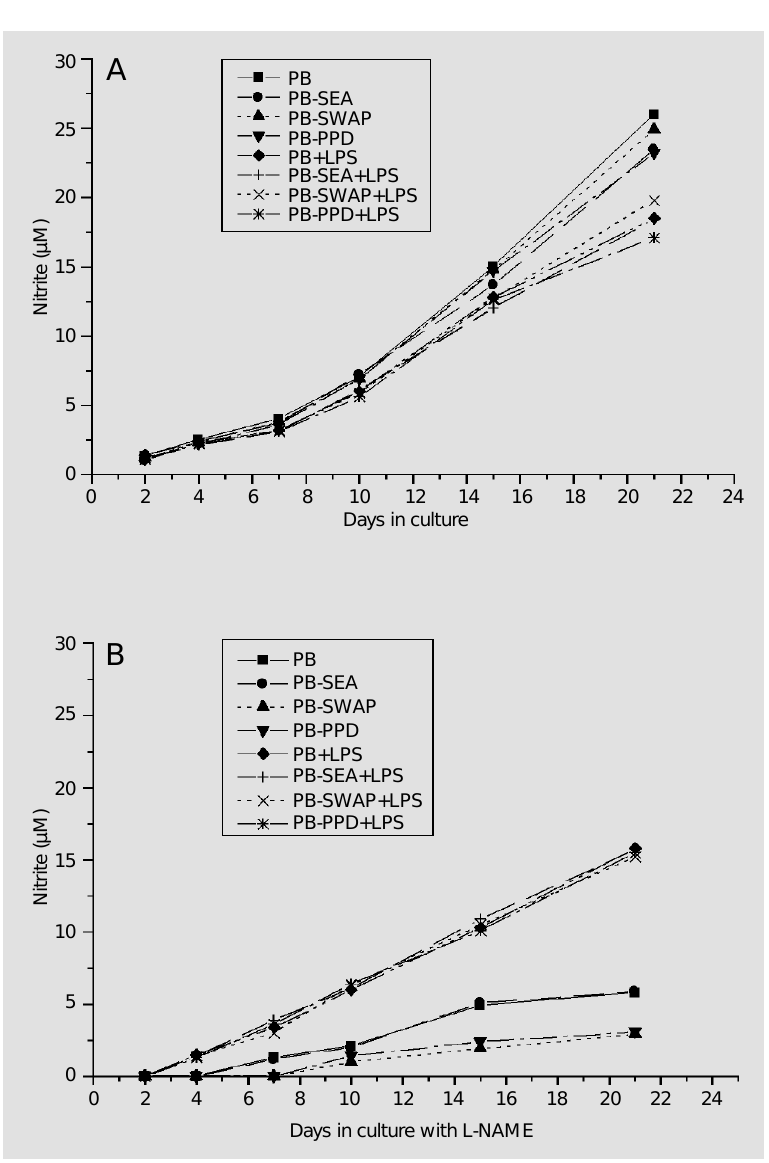
Figure 1 - Panel A , Effect of LPS on kinetics of NO production by PBMC from schistosomia- sis patients during the in vitro granuloma (IVG) reaction. Cells (3 x 10 5 /well) were cultivated with polyacrylamide beads coated with S. mansoni (PB-SEA and PB-SWAP) or with M. tuberculosis (PB-PPD) antigens or not coated with any antigen (PB). The results are reported as nitrite concentrations (µM) as a function of time and represent the mean of N = 10. The standard deviation did not exceed 15%. All experiments were carried out in triplicate. P<0.05 was taken as the limit of significance. Panel B , Inhibition of NO production by L-N- arginine methyl ester (L-NAME) and its reversal by LPS and kinetics of NO production by cultivated with PB-SEA, PB-SWAP, PB-PPD or PB alone and with L-NAME (1 mM) or